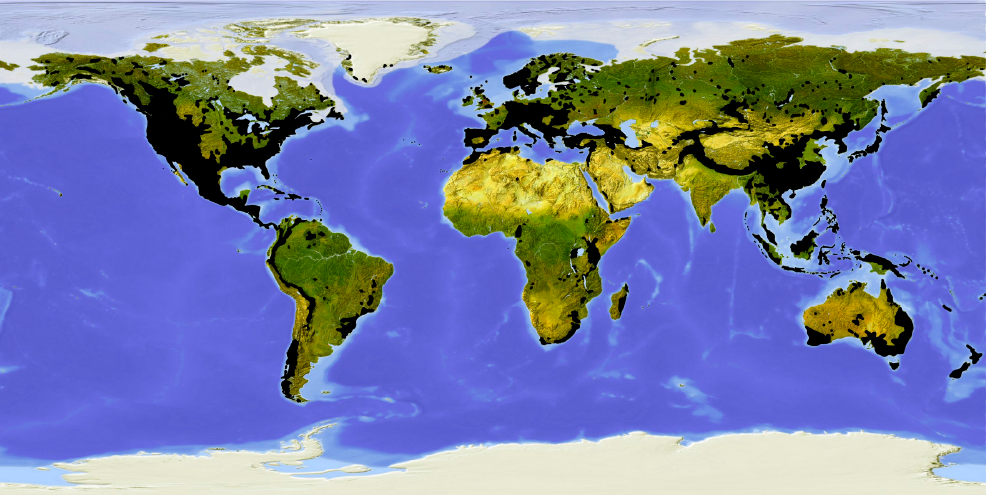
Figure 6. Worldwide distribution of conifers (shown in black) (based on Farjon and Filer [18]). The families Pinaceae, Sciadopityaceae and Taxaceae are virtually confined to the northern hemisphere, whereas Araucariaceae and Podocarpaceae occur in the southern hemisphere and Cupressaceae occurs in